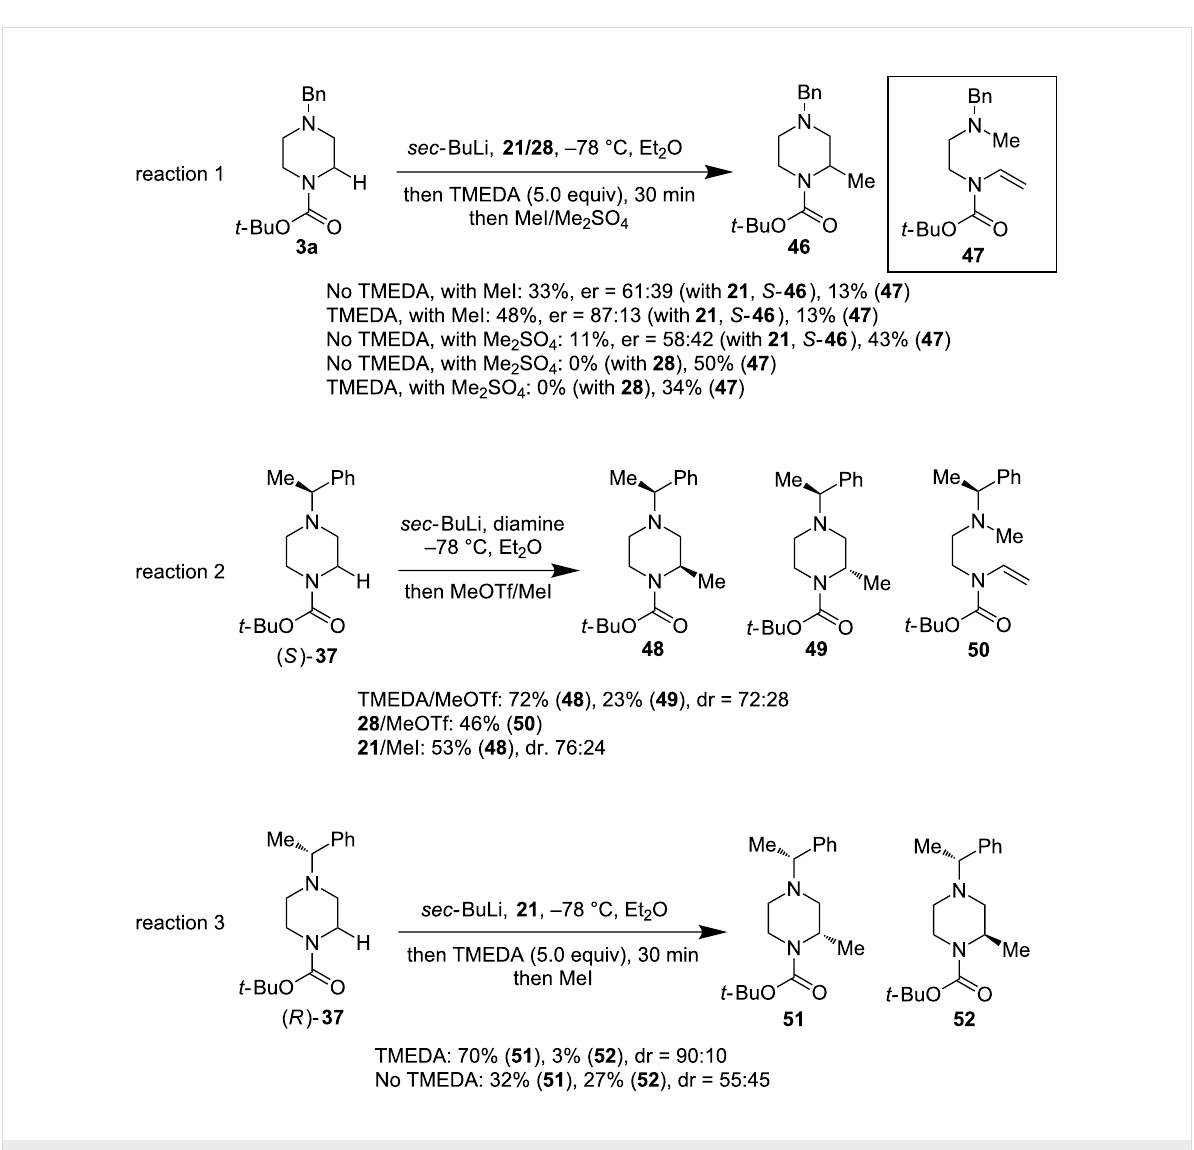
Figure 11: Installation of methyl group at the α -position of piperazines by O’Brien et al. 2016 [43].